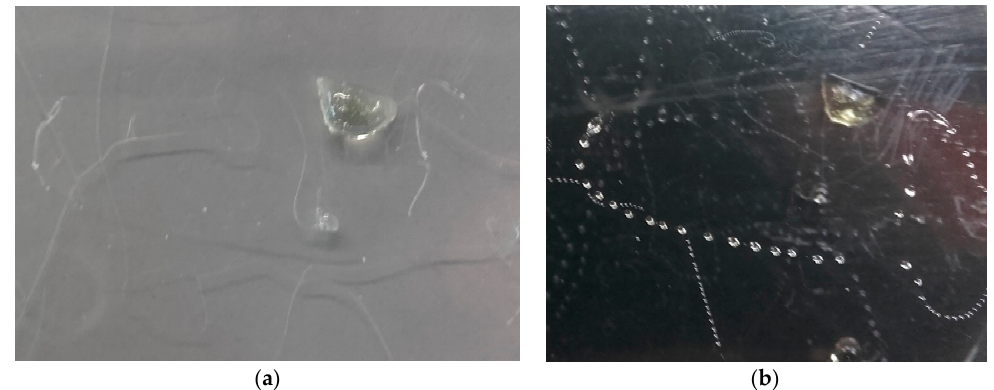
Figure A1. Fibres drawn from a carbohydrate glass solution directly after and 24 h later ( a ) Intact fibres of carbohydrate glass in random shapes and sizes; ( b ) Same fibres but now 24 h later. Fibres are mostly dissolved into droplets with only the larger pieces of carbohydrate glass still recognisable.